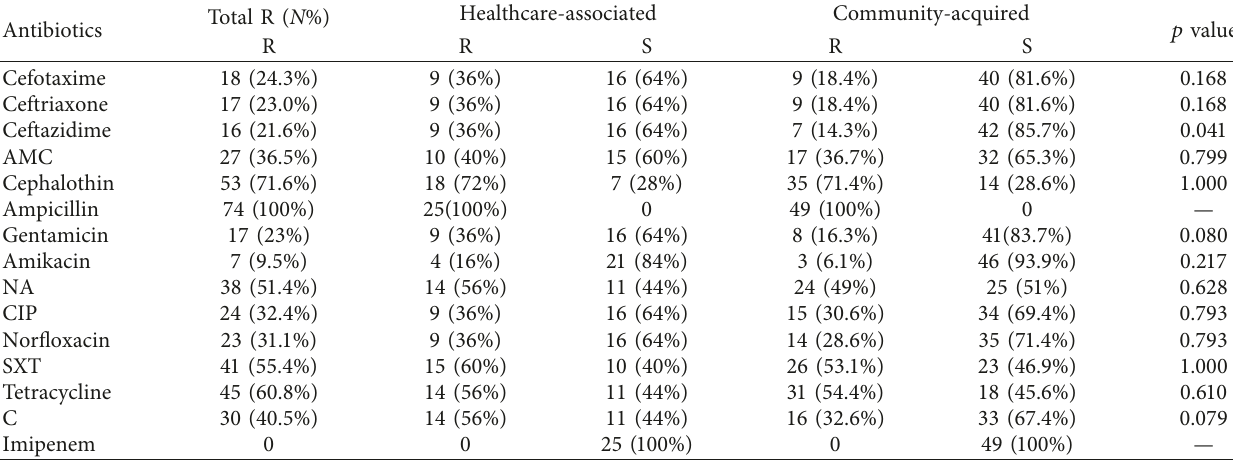
Table 4: Resistance profiles of isolates from healthcare-associated versus true community-acquired in JUSH, Southwest of Ethiopia. Total R ( N %) Healthcare-associated Community-acquired Antibiotics